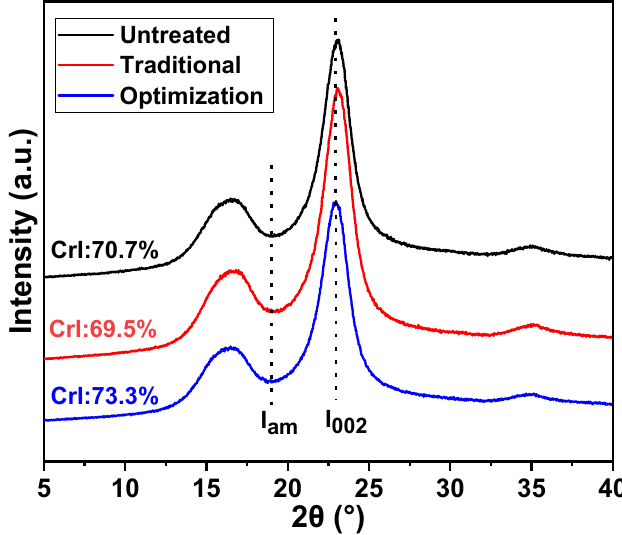
Figure 6. Distribution of crystalline and non-crystalline regions of eucalyptus pulp fiber under different chlorine dioxide oxidation conditions.